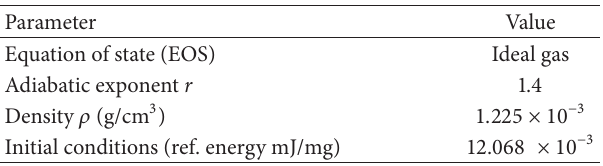
Table 3: Air parameter.